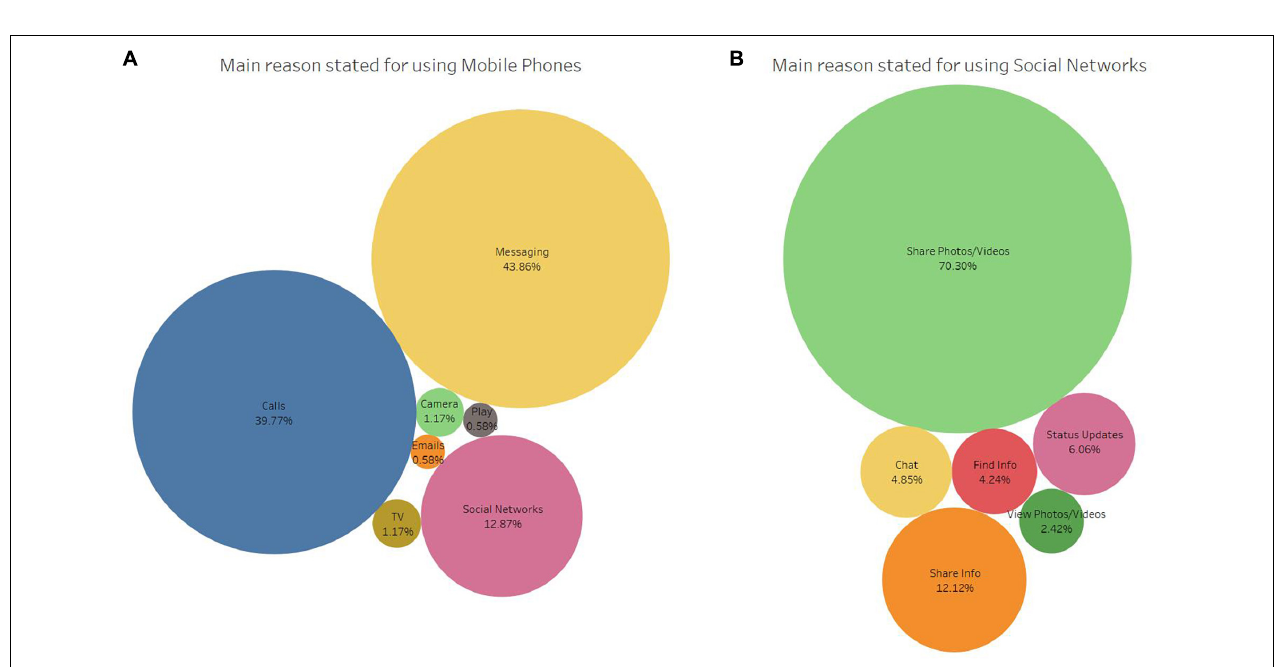
FIGURE 2 | The participants’ self-reported, main reason for using mobile phones (A) and social networks (B) .